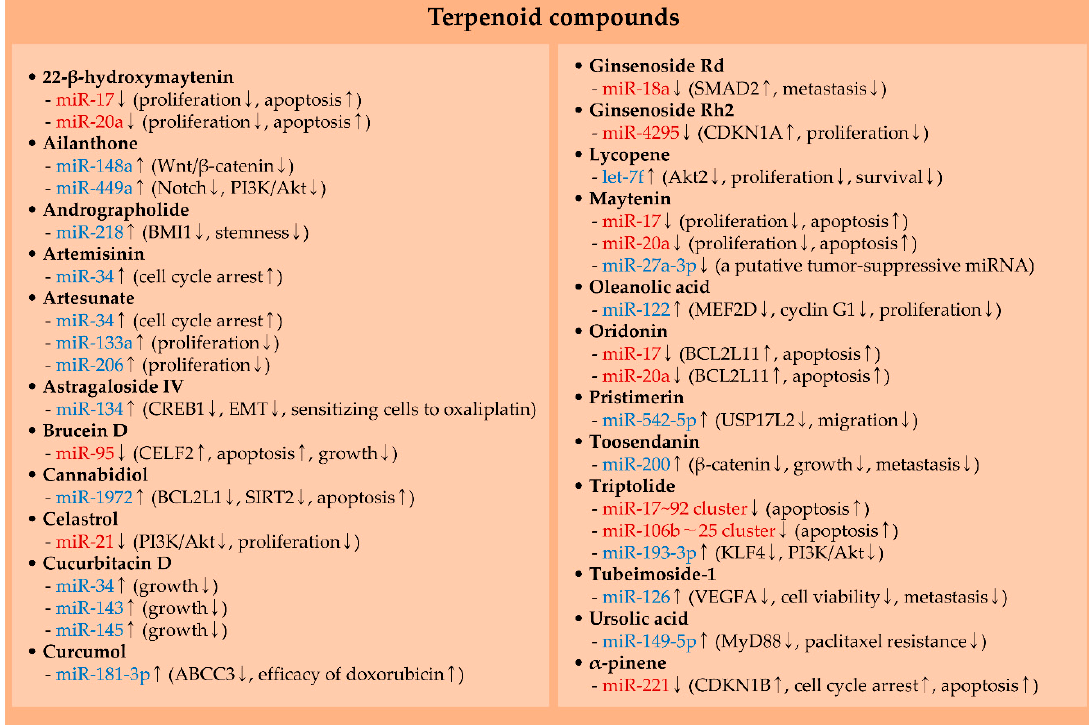
Figure 3. Effects of terpenoid compounds on the expression level of oncogenic miRNAs (red) and tumor-suppressive miRNAs (blue). Arrows indicate the upregulation ( ↑ ) and downregulation ( ↓ ) of miRNA levels and consequential effects on cancer. The role of miRNAs in cancer therapy with phytochemicals is described in Sections 2 and 3.